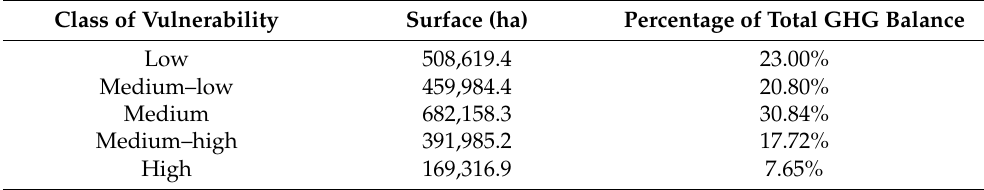
Table 3. Detail of the surfaces of the GHG balance classes.